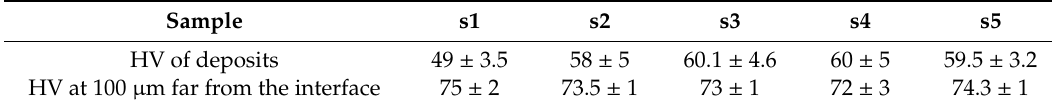
Table 3. Average hardness value (HV300 / 15) of deposit and of substrate at 100 µ m far from the interface substrate / deposit.